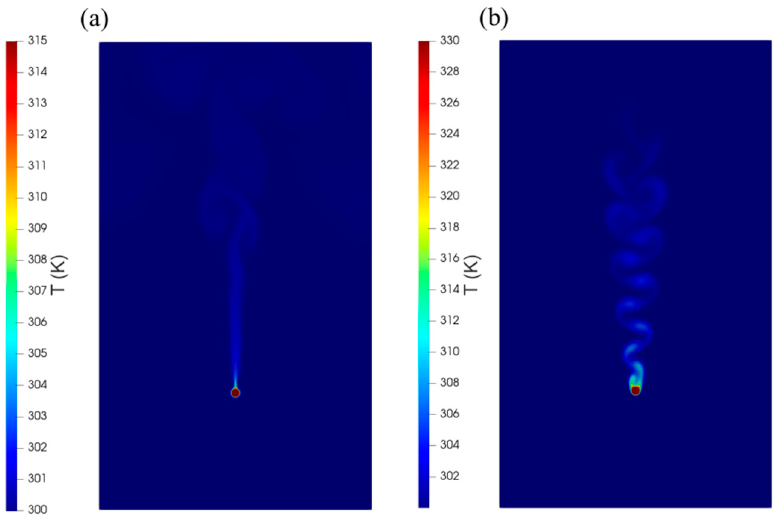
Figure 5. Temperature distributions of ( a ) natural and ( b ) forced convections.